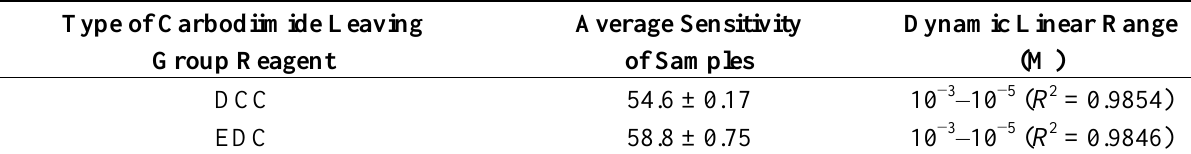
-urease-modified SPE electrode. 60